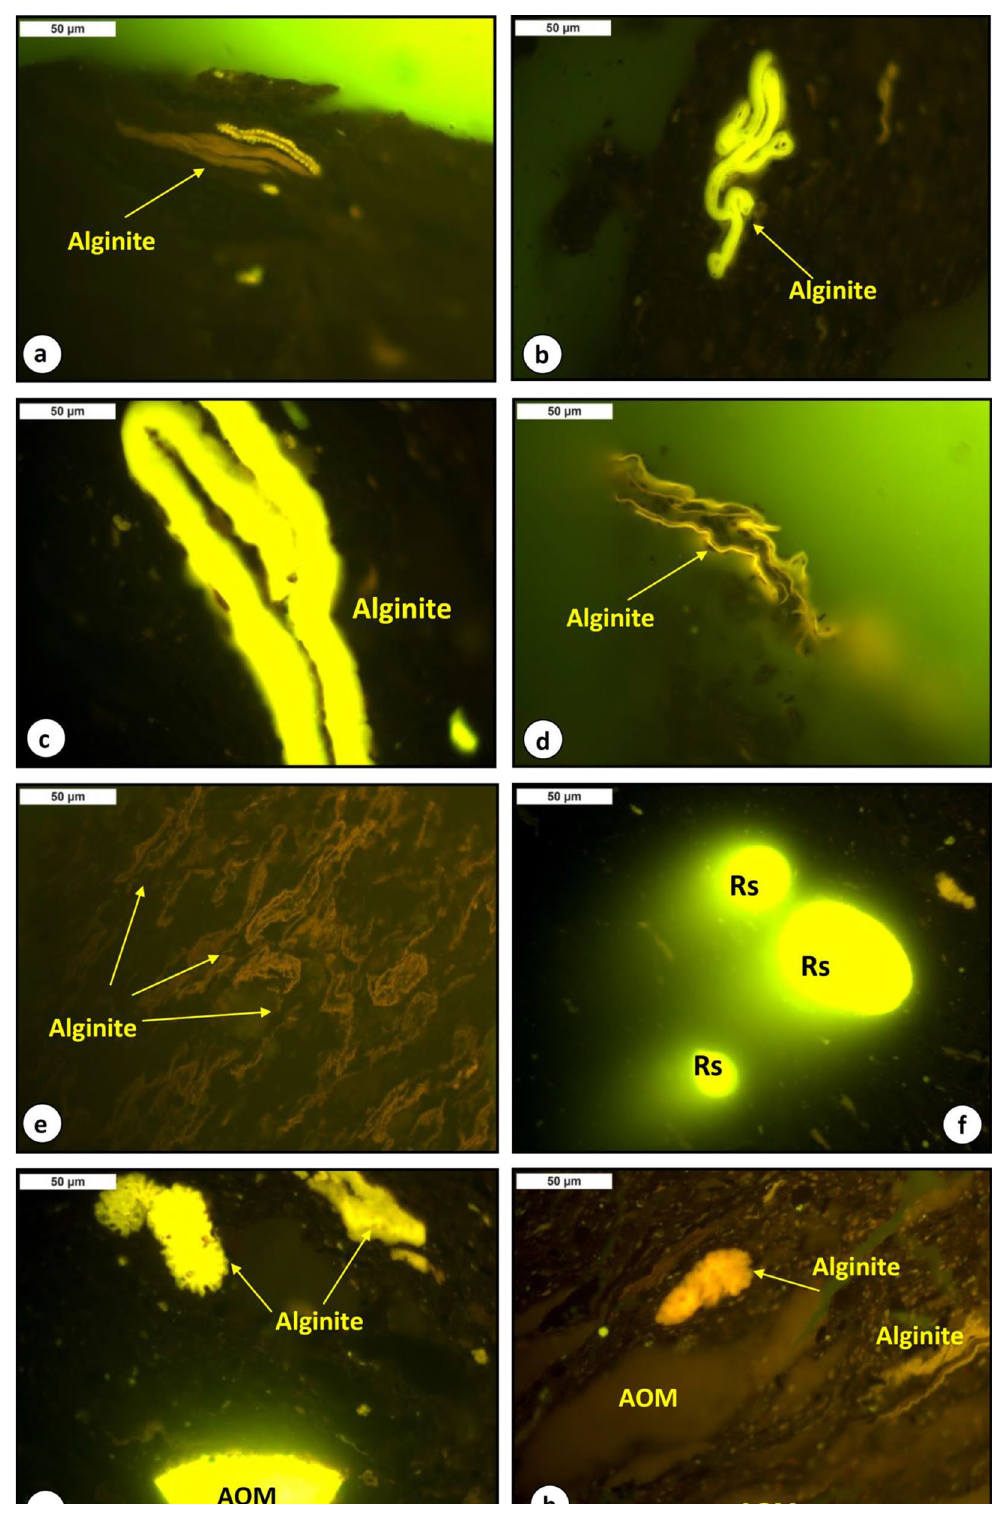
Figure 5. Photomicrographs of organic matter assemblage from the analyzed bituminous shales in the Paleocene Palana Formation; under UV light, field width = 0.2 mm: ( a – e ) yellow and brownish-yellow fluorescence alginite assemblages of mainly telalginite and lamalginite , ( f ) bright yellow fluorescing resinite (Rs), and ( g and h ) mixed organic matter of yellow and brownish-yellow fluorescence alginite assemblages of mainly Botryococcus and yellow and brownish-yellow fluorescence